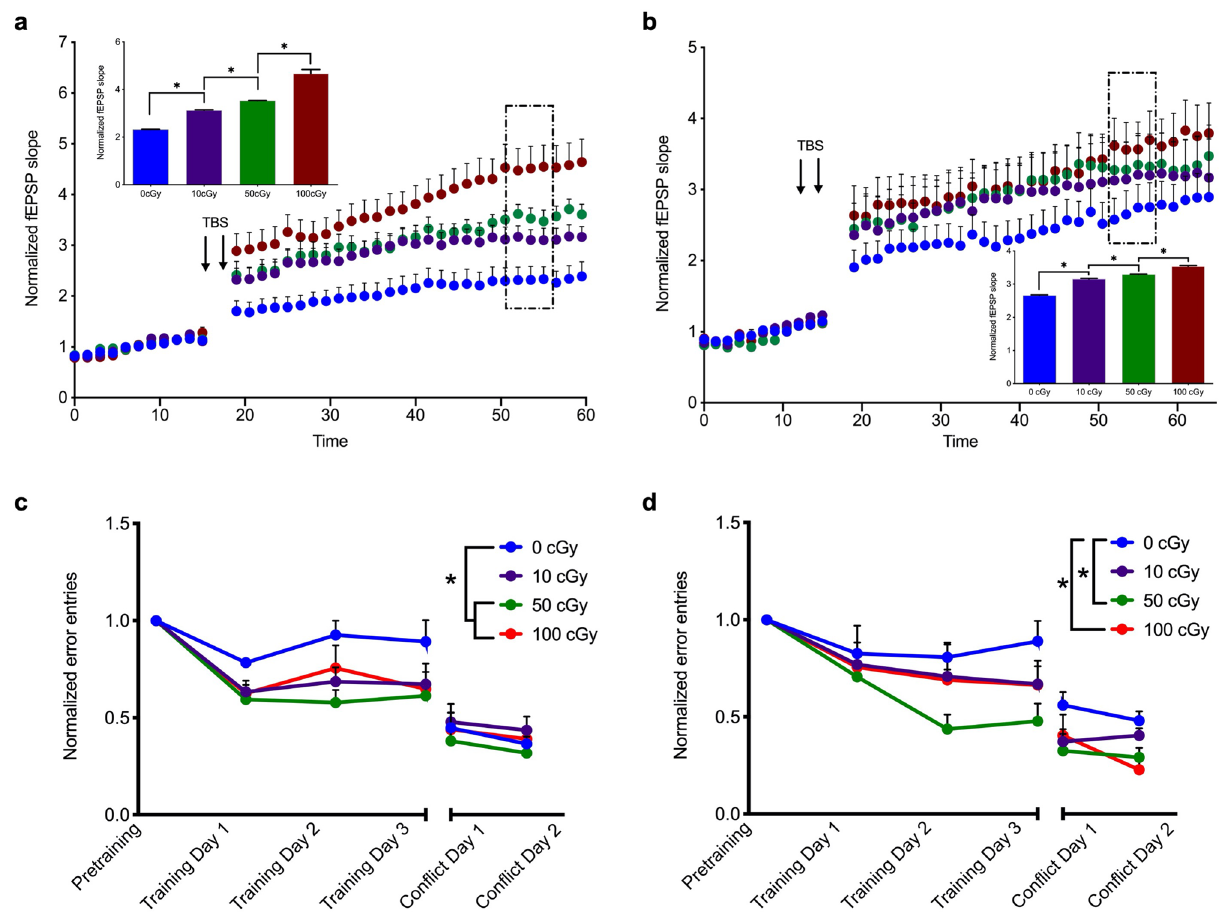
Figure 4. Enhancements in Schaffer collateral-CA1 LTP and spatial learning 12 months after exposure to 56 Fe particle radiation ( a , b ) Time course and magnitude (inset bar graph) of LTP in slices from mice exposed to 10 cGy, 50 cGy, or 100 cGy radiation, compared to sham-irradiated controls (0 cGy). After a 15 min baseline, LTP was elicited by two high-frequency TBS stimulus trains (arrows), and magnitude of LTP between 35 and 40 min post TBS (perforated box) was compared across doses in ( a ) male mice, One-way RM ANOVA, F(1.73,17.31) = 3137.0, P < 0.001, Tukey’s post hoc test: 0 cGy vs. 10 cGy, P < 0.0001; 0 cGy vs. 50 cGy, P < 0.0001; 0 cGy vs. 100 cGy, P < 0.0001, 10 cGy vs. 50 cGy, P < 0.0001, 10 cGy vs. 100 cGy, P < 0.0001 , 50 cGy vs. 100 cGy, P < 0.0001 and ( b ) female mice, One-way RM ANOVA, F(2.48,24.77) = 449.1, P < 0.0001, Tukey’s post hoc test: 0 cGy vs. 10 cGy, P < 0.0001; 0 cGy vs. 50 cGy, P < 0.000 1 ; 0 cGy vs. 100 cGy, P < 0.0001, 10 cGy vs. 50 cGy, P < 0.0001, 10 cGy vs. 100 cGy, P < 0.0001, 50 cGy vs. 100 cGy, P < 0.0001. * P < 0.05 compared to 0 cGy, n = 12–16 slices per dose per sex. ( c , d ) Learning curves, including pretraining, training days 1–3, and conflict training days 1–2, are shown for (c) male mice Two-way RM ANOVA, dose : F(3,16) = 2.78, P = 0.08; trial : F(1.933,30.93) = 54.98, P < 0.0001; interaction : F(15,80) = 1.31, P = 0.21 , Tukey’s post hoc test: Training Day 1, 0 cGy vs. 50 cGy, P = 0.008, 0 cGy vs. 100 cGy, P = 0.045, Training Day 2, 0 cGy vs. 50 cGy, P = 0.019 and (d) female mice Two-way RM ANOVA, dose : F(3,16) = 2.57, P = 0.09; trial : F(2.445,39.12) = 47.93, P < 0.0001; interaction: F(15,80) = 1.23, P = 0.266, Tukey’s post hoc test: Training Day 2, 0 cGy vs. 50 cGy, P = 0.021, Training Day 3, 0 cGy vs. 50 cGy, P = 0.044, Conflict Day 2, 0 cGy vs. 100 cGy, P = 0.038, as a function of normalized number of entries into the stationary shock zone (Errors). * P < 0.05, n = 5 mice per dose per sex. Each point represents mean errors normalized to pre-training entries ±